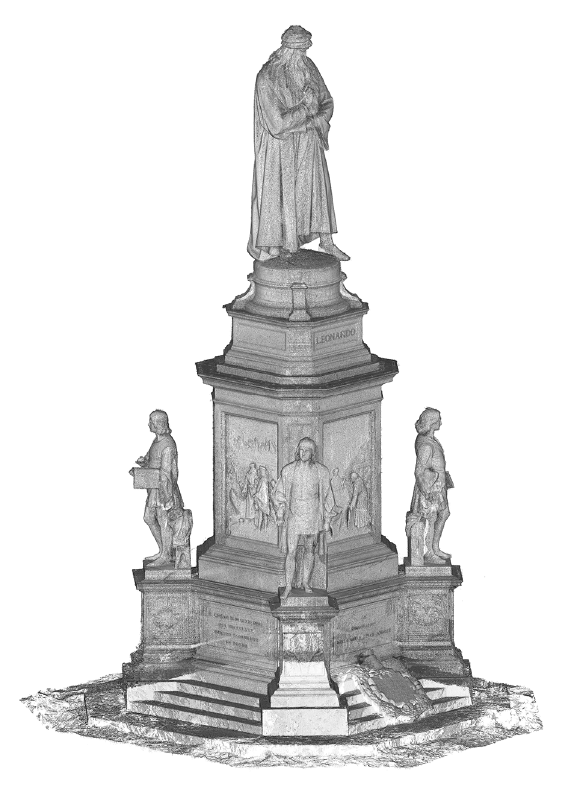
Figure 3. Point cloud of the statue registered in Cyclone The Geomagic Studio (Figure 4) reverse modelling software was used to process the data. The single point clouds were first filtered to remove isolated points and partially acquired